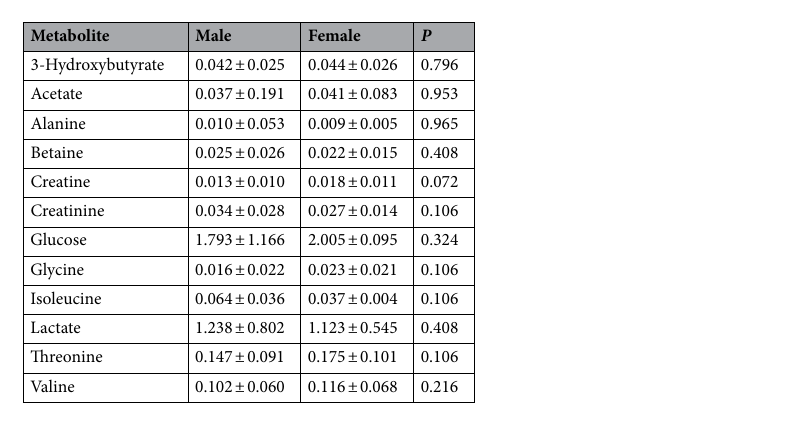
Table 3. Metabolite concentration (mmol/L) derived from deproteinized spectra samples according to the sex. P values were corrected for multiple comparisons.